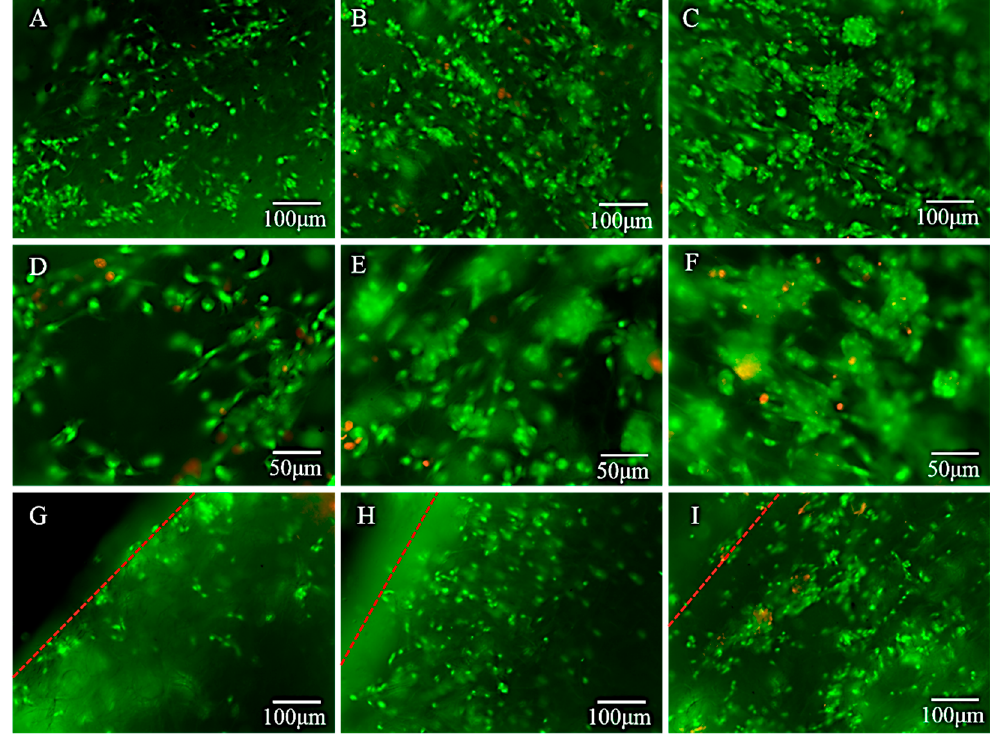
Figure 6. AO/EB double fluorescence staining of NIH 3T3 cultured on 3D nanofibrous scaffolds. ( A – C ) Images of the transversal section after 1, 3, and 7 days with 10× objective lens. ( D – F ) Images with 20× objective lens corresponding to ( A – C ). ( G – I ) Vertical sections corresponding to ( A – C ). The red dotted lines represent the surface of the scaffolds.